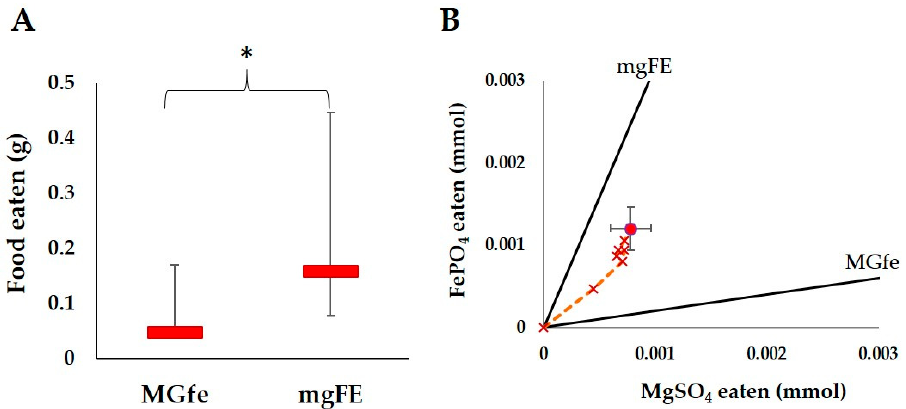
Figure 3. Results of the feeding trial in termites exposed to the food varying in MgSO 4 and FePO 4 (MGfe and mgFE diets). ( A ) Medians (red bar) and quartiles (error bars) of the total amount of food eaten for all colonies (N = 10) after 14 days. The “*” indicates a significant difference between the amount of each diet consumed ( p < 0.01); ( B ) The nutritional intake of the termites for MgSO 4 and FePO 4 over a 14 days period. The lines and symbols are the same as in Figure 2, except the large circle and x’s are in red and the nutrient rails represent the ratio of MgSO 4 and FePO 4 in both food types.